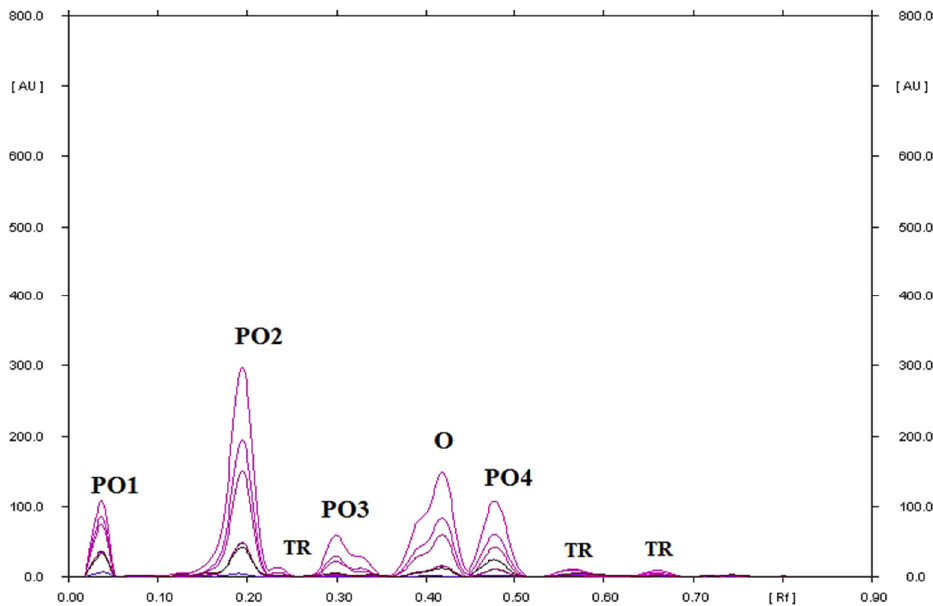
Figure 3. TLC-UV densitograms recorded in the multi wavelength from 200 to 380 nm (at wavelength intervals of 30 nm at each step) of ornidazole heated on silica gel at 120 °C for 24 which was next separating using chloroform–methanol (9:1, v / v ) as mobile phase, where O is ornidazole, PO1, PO2, PO3, and PO4 are the degradation products of ornidazole, and TR is the traces. At 80 °C, tinidazole is relatively stable, and 92.33% of it remains (Figure 2). However,